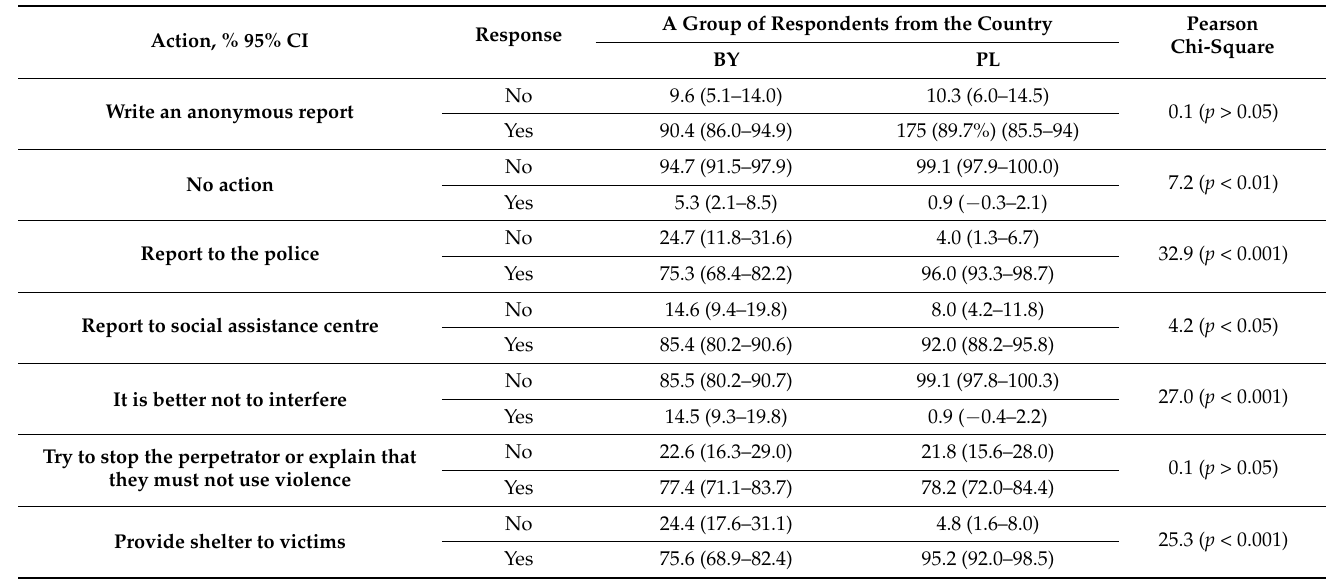
Table 3. Opinions on action to be taken in the event of suspected violence or when witnessing violence.